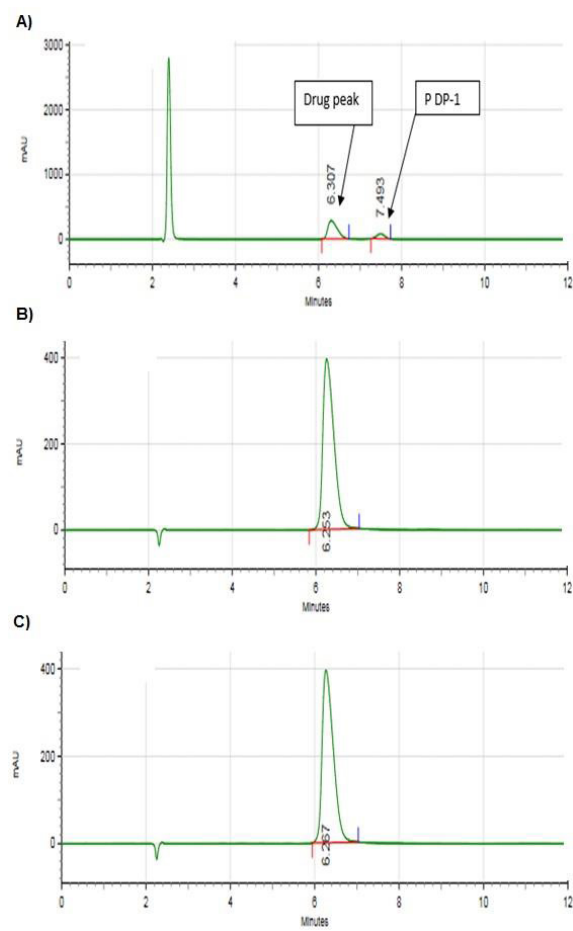
FIGURE 4 - Representative chromatogram of stress samples after degradation in A) Oxidative B) Thermal and C) Photolytic conditions.